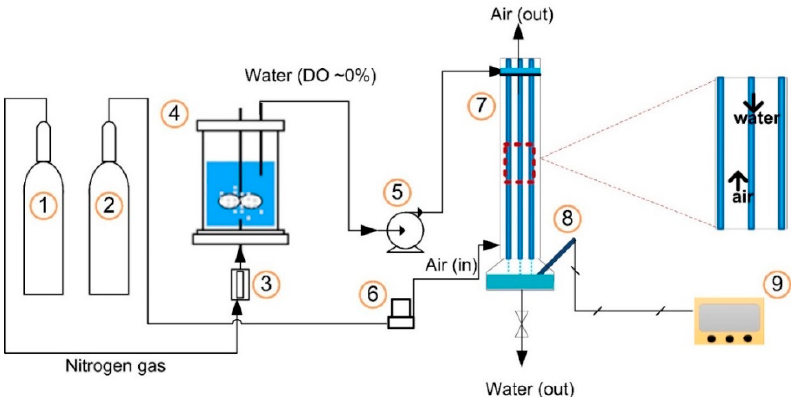
Figure 7. Mass transfer experiment setup: (1) Nitrogen gas tank; (2) Air (or air–methane) gas tank; (3) Nitrogen gas rotameter; (4) Water holding tank; (5) Peristaltic pump; (6) Mass flow controller; (7) SFR; (8) DO electrode; and (9) Data acquisition unit.